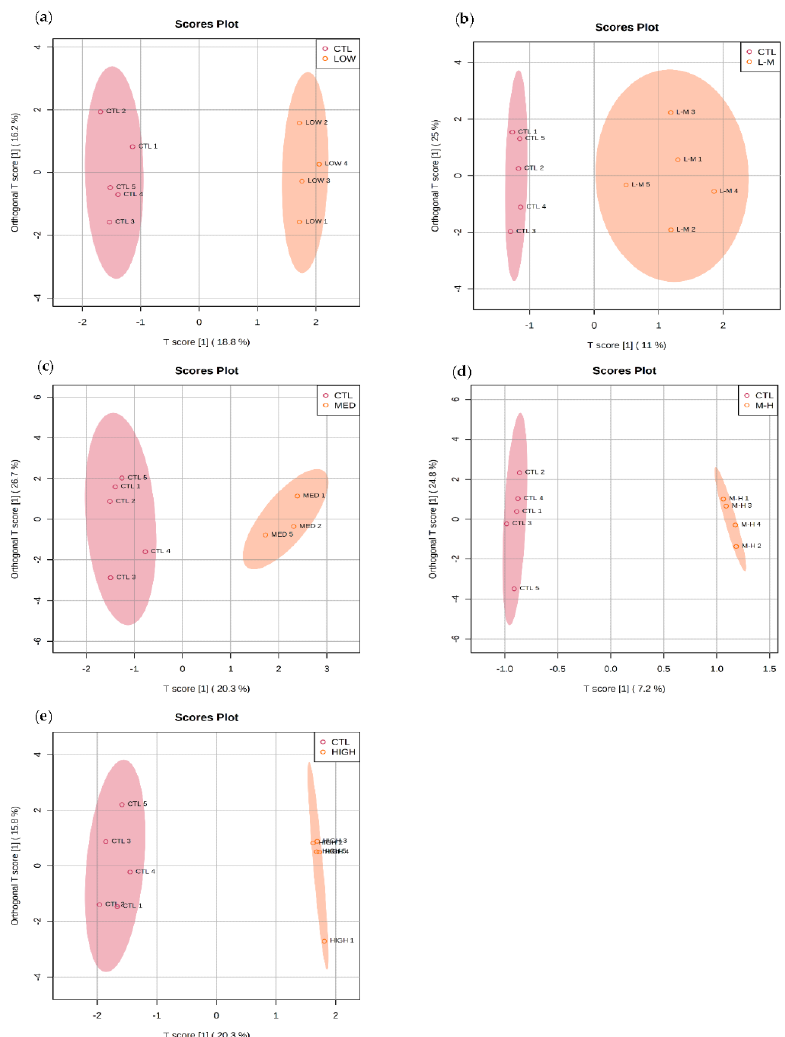
Figure 6. Orthogonal PLS-DA: separation of polar metabolites from amphipods exposed to PFHxS for 7 days at ( a ) low (0.03 µ g/L), ( b ) low–medium (0.15 µ g/L), ( c ) medium (0.76 µ g/L), ( d ) medium–high (3.78 µ g/L) and ( e ) high (18.92 µ g/L) concentrations. Orthogonal PLS-DA model overview can be found in Supplementary Materials (Figures S13–S17). Table 4. Significantly changed metabolites identified from a one-way ANOVA following exposure to PFHxS compared to controls. Values in bold represent statistical significance following Tukey’s post hoc test. All values listed are BH-adjusted p values ( p < 0.05) using a 95% family-wise confidence level. Degrees of freedom =